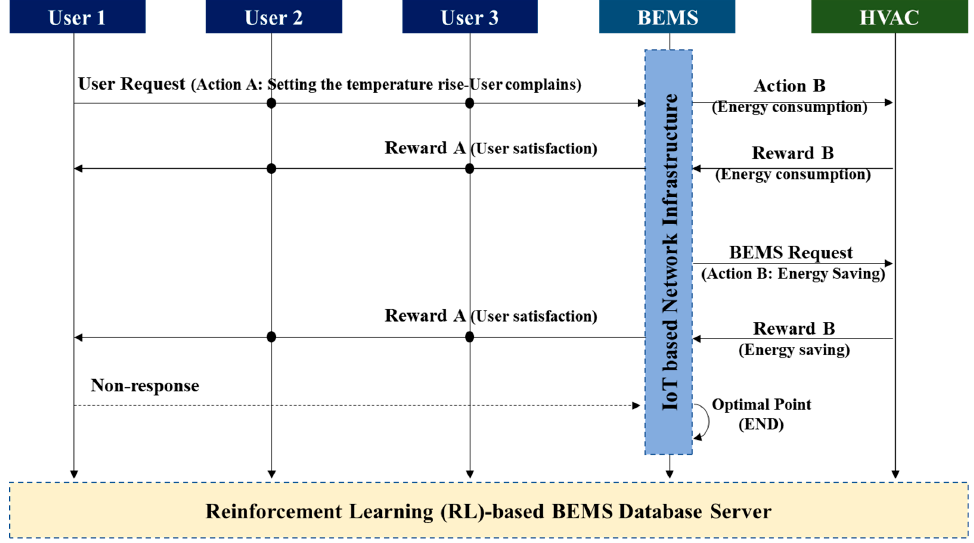
Figure 2. Agent–environment interaction in an RL-based BEMS.